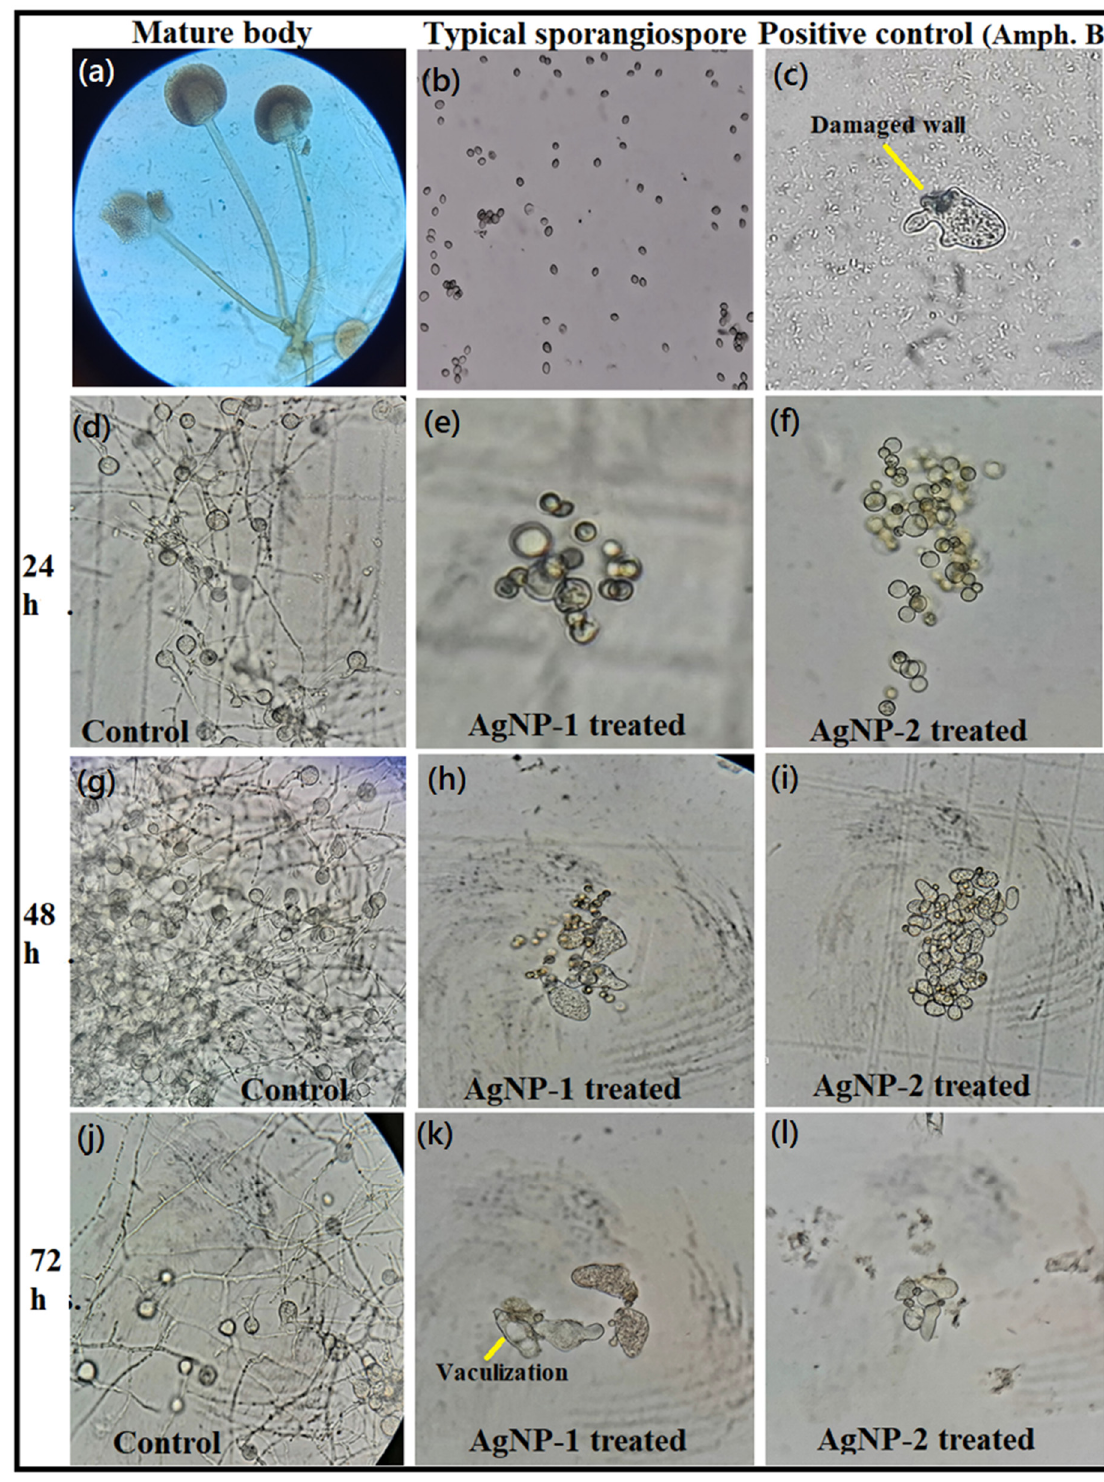
Figure 3. Assessment of anti-sporangiospore activity of PEI-f-Ag-NPs. ( a ) Wet mounted vegetative body of R. arrhizus with sporangiospore, ( b ) freshly harvested sporangiospores, ( c ) sporangiospores treated with amphotericin B for 24 h, ( d ) control sporangiospores at 24 h, ( e ) treated with PEI-f-AgNP- 1 for 24 h, ( f ) treated with PEI-f-AgNP-2 for 24 h, ( g ) control sporangiospores at 48 h, ( h ) treated with PEI-f-AgNP-1 for 48 h, ( i ) treated with PEI-f-AgNP-2 for 48 h, ( j ) control sporangiospores at 72 h, ( k ) treated with PEI-f-AgNP-1 for 72 h, and ( l ) treated with PEI-f-AgNP-2 for 72